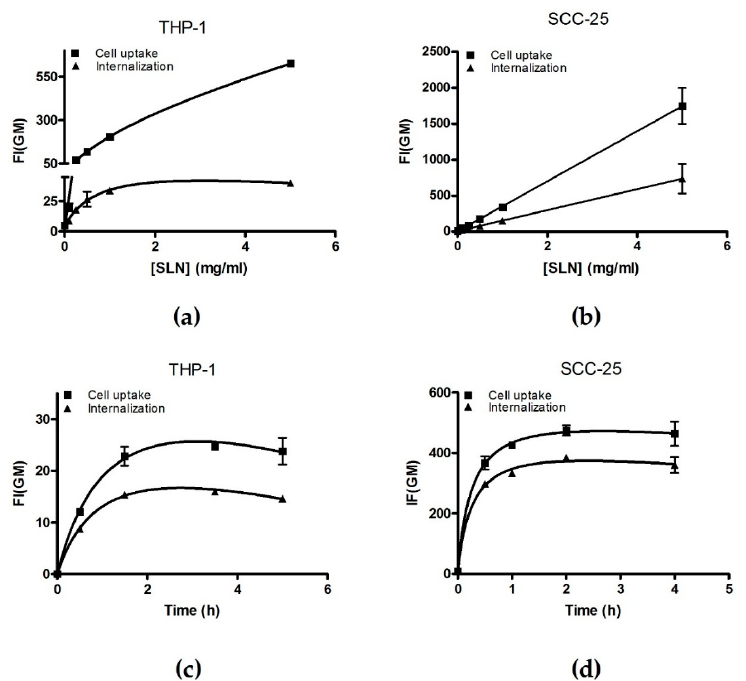
Figure 3. Non-coated fSLN incorporation is concentration and time dependent. THP-1 cells were seeded at 10 5 cells/mL and ( a ) treated with different concentrations of fSLN for 2 h or ( b ) treated with 0.25 mg/mL of fSLN for different incubation periods. SCC-25 cells were seeded at 1.5 × 10 5 cells/well in 6-well plates and incubated overnight. Next day, cells were washed and treated with different concentration of fSLN for 2 h ( c ) or incubated with 0.25 mg/mL fSLN for indicated periods of time ( d ). Then, cells were washed in PBS and collected in order to measure GeoMean of the fluorescence intensity (FI(GM)) of incorporated C 12 -FITC by flow cytometry. Samples measured without trypan blue are indicated as cell uptake ( (cid:4) ) and samples measured with trypan-blue are indicated as probe internalization ( (cid:78) ). Results are the mean ± Range of two independent experiments. Total binding saturation curve was calculated in order to facilitate data